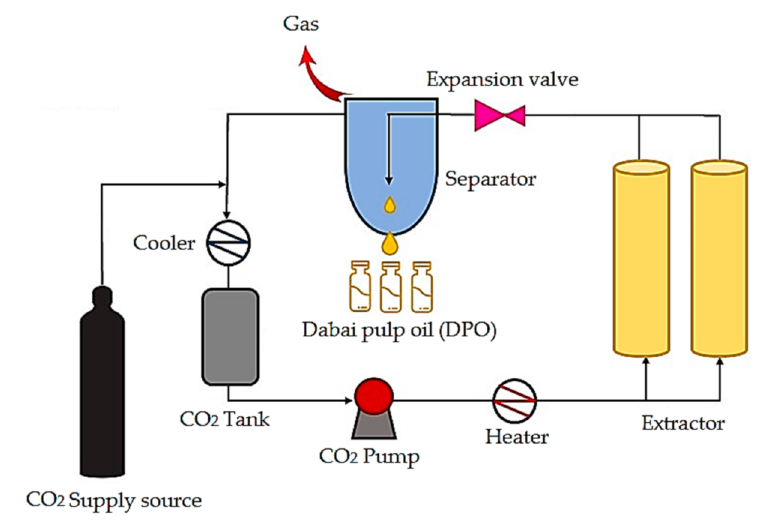
Figure 1. Schematic diagram of the supercritical carbon dioxide extraction